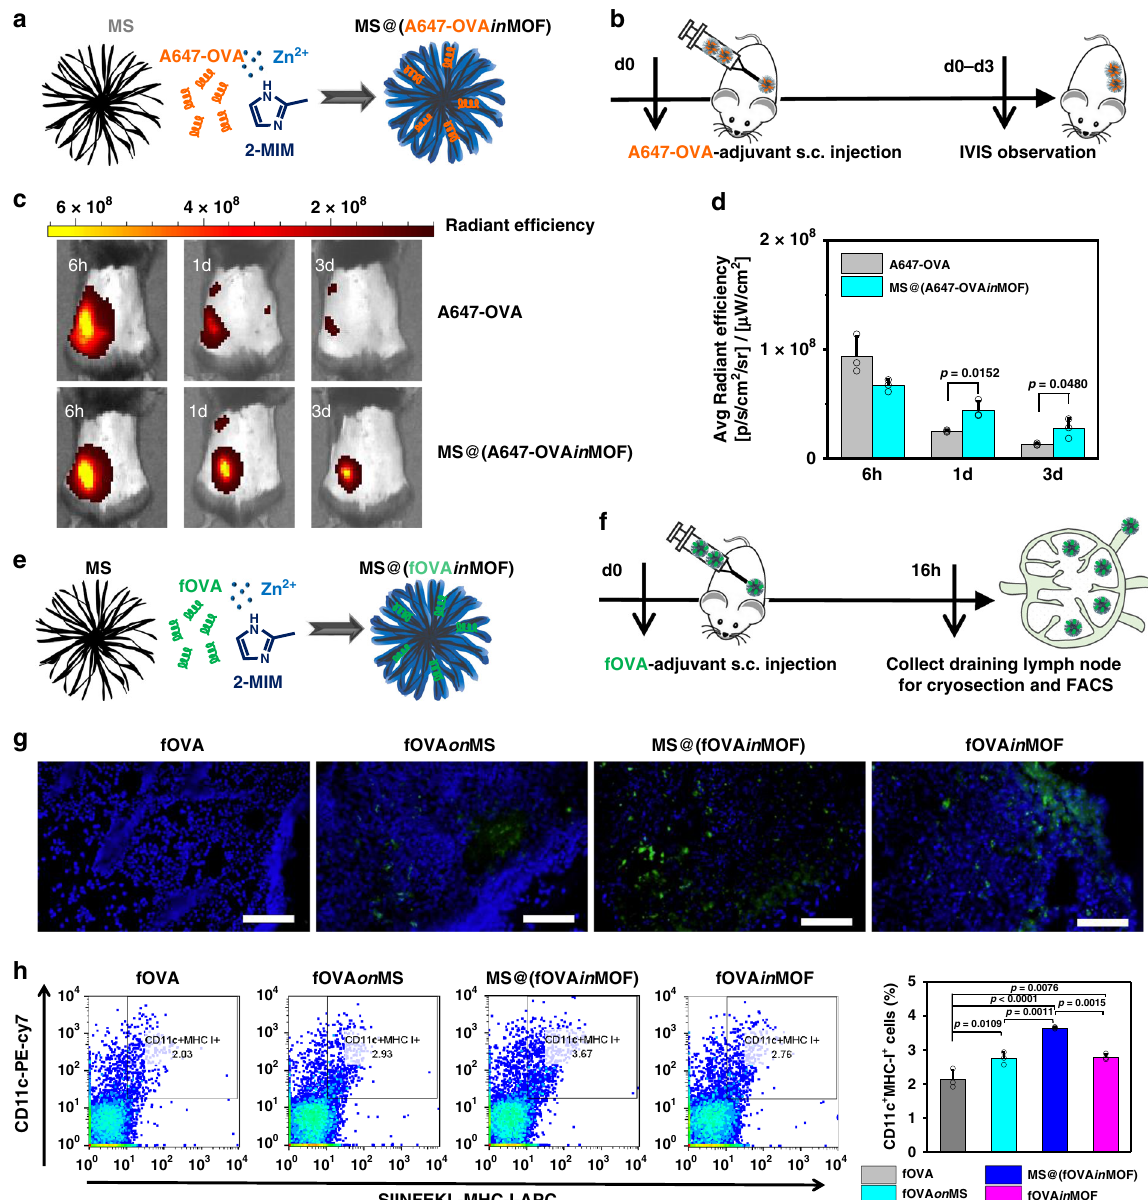
Fig. 3 Antigen retention at vaccination site and delivery to lymph nodes. a Scheme of MS@(A647-OVA in MOF) fabrication. b Timeline of the injection of free A647-OVA and MS@(A647-OVA in MOF), and IVIS observation. c Representative images of A647-OVA model cancer antigen residues at the injection sites observed by IVIS fl uorescent imaging system for free A647-OVA (upper) and MS@(A647-OVA in MOF) (lower). d Quantitative analysis of A647-OVA fl uorescent intensity at the injection site at 6 h, 1 day and 3 day ( n = 3 independent animals; Student ’ s t test, two-tailed). e Scheme of MS@ (fOVA in MOF) fabrication. f Timeline of the injection of free fOVA and fOVA-loaded nanoadjuvants and subsequent collection of lymph nodes for cryosection and fl ow cytometry analysis. g Representative cryosection images of lymph nodes in mice vaccinated with: fOVA, fOVA on MS, MS@ (fOVA in MOF) and fOVA in MOF. DAPI, blue; fOVA, green. Scale bars, 50 μ m. h Representative fl ow cytometry plots (left) and populations (right) of CD11c + MHC-I + dendritic cells with antigen cross-presentation in lymph nodes in mice vaccinated with: fOVA, fOVA on MS, MS@(fOVA in MOF) and fOVA in MOF ( n = 3 independent samples, one-way ANOVA followed by Tukey ’ s multiple comparisons post hoc test, p < 0.0001). All data ( d ; h , right panel) are presented as mean + Combination immunotherapy of MOF-gated MS vaccination injection of the anti-PD-1 Ab at a dose of 0, 20, or 200 μ g per and PD-1 blockade . We explored combination immunotherapy mouse on days 3, 7, 14, and 21 post-tumour inoculation. The pre- using the subcutaneous (s.c.) administration of MOF-gated MS established tumours on the right fl ank were designated distant cancer vaccines plus intraperitoneal (i.p.) injection of anti-PD-1 Ab tumours without direct treatment since the subsequent cancer (Figs. 5 and 6a, b; Supplementary Figs. 31 – 33). A therapeutic mouse immunotherapy was administrated at different body sites. Mice tumour model was established by s.c. injecting E.G7-OVA cancer were divided into nine treatment groups as shown in Table 1. cells into the right fl ank region of the mice (C57BL/6), followed by Combination of MOF-gated MS vaccination with PD-1 the s.c. injection of cancer vaccines into the left fl ank region plus i.p. blockade at a low dose signi fi cantly improves the therapeutic